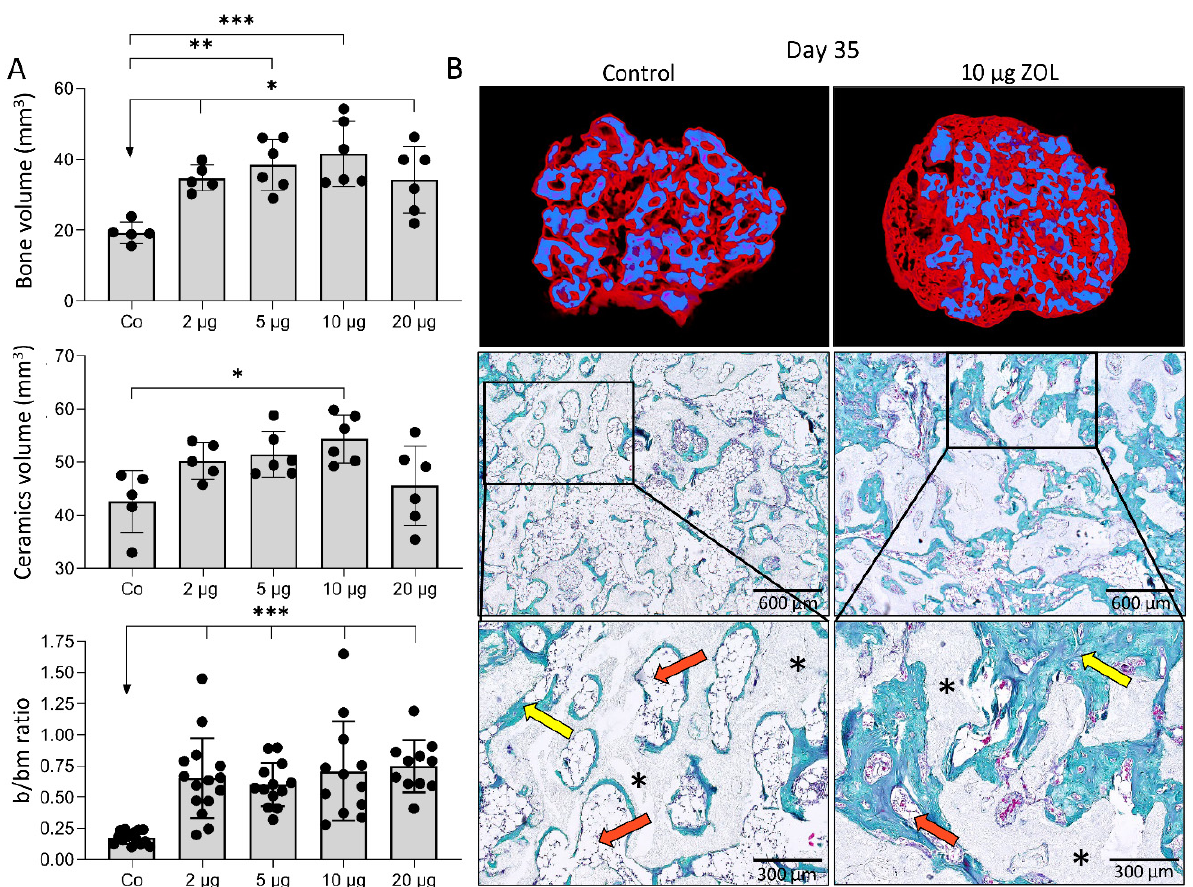
Figure 2. Different doses of ZOL increased bone volume and affected bone microarchitecture 35 days following subcutaneous implantation of ABGS (rhBMP6/ABC) implants with ceramics. ( A ) Bone volume (mm 3 ) and ceramics volume (mm 3 ) quantified by microCT analyses, and histomorphometrically determined bone/bone marrow (b/bm) ratio among control implants (Co) and implants with different doses of ZOL (2, 5, 10 and 20 µg). ( B ) Newly formed bone (red) and ceramics (blue) are shown on 3D reconstruction slices (1st row). Histological sections (Goldner stain) (2nd and 3rd row) of bone-ceramic structure induced by control and implants with 10 µg ZOL. Newly formed bone is marked with yellow arrows, while bone marrow is indicated with orange arrows. Black asterisks indicate ceramic particles. Scale bars are shown in the lower right corner. All P values below 0.05 were considered significant and are marked with asterisks as follows: * ( p ≤ 0.05), ** ( p ≤ 0.01), *** ( p ≤ 0.001).